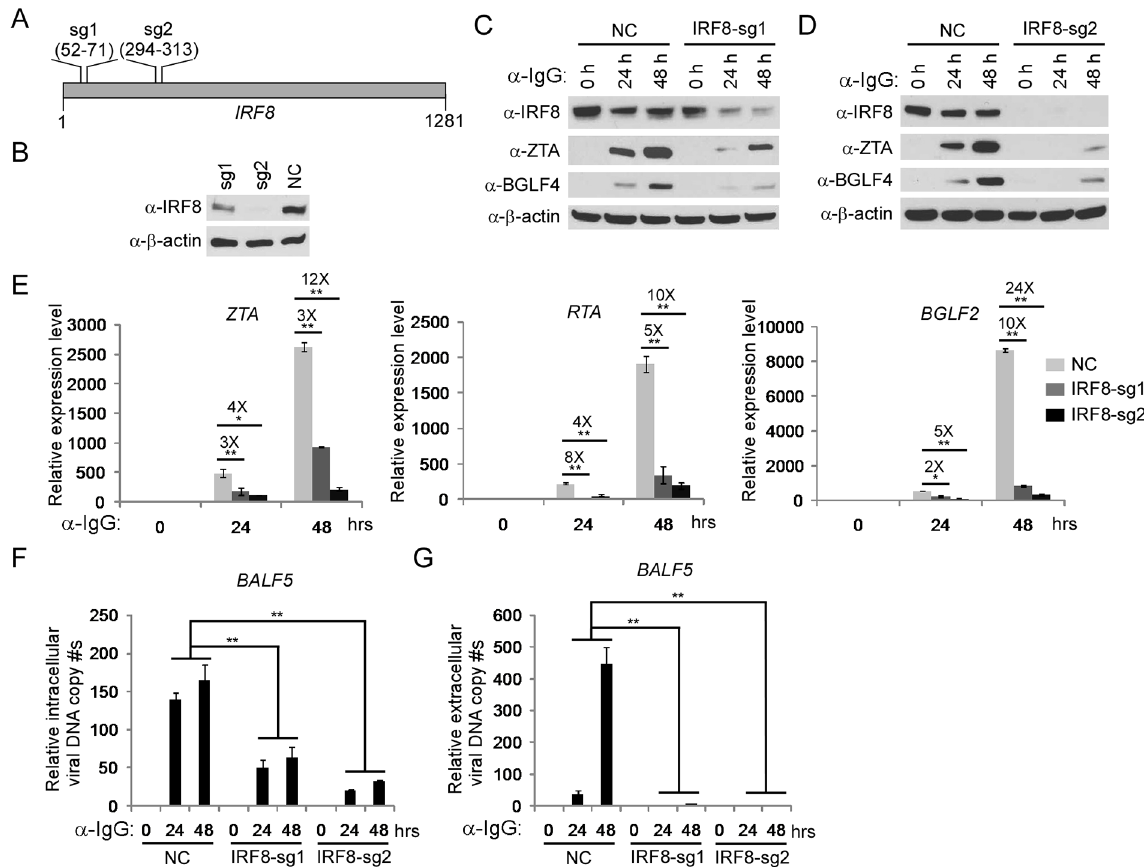
Fig 1. IRF8 depletion inhibits the reactivation of EBV in Akata (EBV + ) cells. A. The locations of two sgRNAs (sg1 and sg2) used for IRF8 depletion. B. Western blot was performed to check the knockdown efficiency of IRF8 by sg1 and sg2 compared with the non-targeting control sgRNA (NC). C-G. IRF8 -depleted (sg1 and sg2) and control (NC) Akata (EBV + ) cells were either untreated (0 hr) or treated with anti-IgG for 24 and 48 hrs to induce lytic replication. The cell pellets and supernatant was harvested 24 and 48 hrs after anti-IgG stimulation. Protein extracts were analyzed by western blot using antibodies against IRF8 and EBV immediate-early (ZTA) and early (BGLF4) proteins (C and D). RT-qPCR showing the suppression of EBV immediate-early ( ZTA and RTA ) and late ( BGLF2 )genes expression upon IRF8 depletion (sg1 and sg2) (E). qPCR showing the reduction of intracellular viral DNA (F) and extracellular virion-associated DNA (G) copy numbers upon IRF8 depletion. The EBV genome copy number was measured by qPCR using primers specific to EBV BALF5 . The intracellular EBV copy number was normalized by qPCR using specific primers to β -actin . Data are presented as means ± standard deviations ( n = 3). (cid:3) p < 0.05 and (cid:3)(cid:3) p < 0.01.